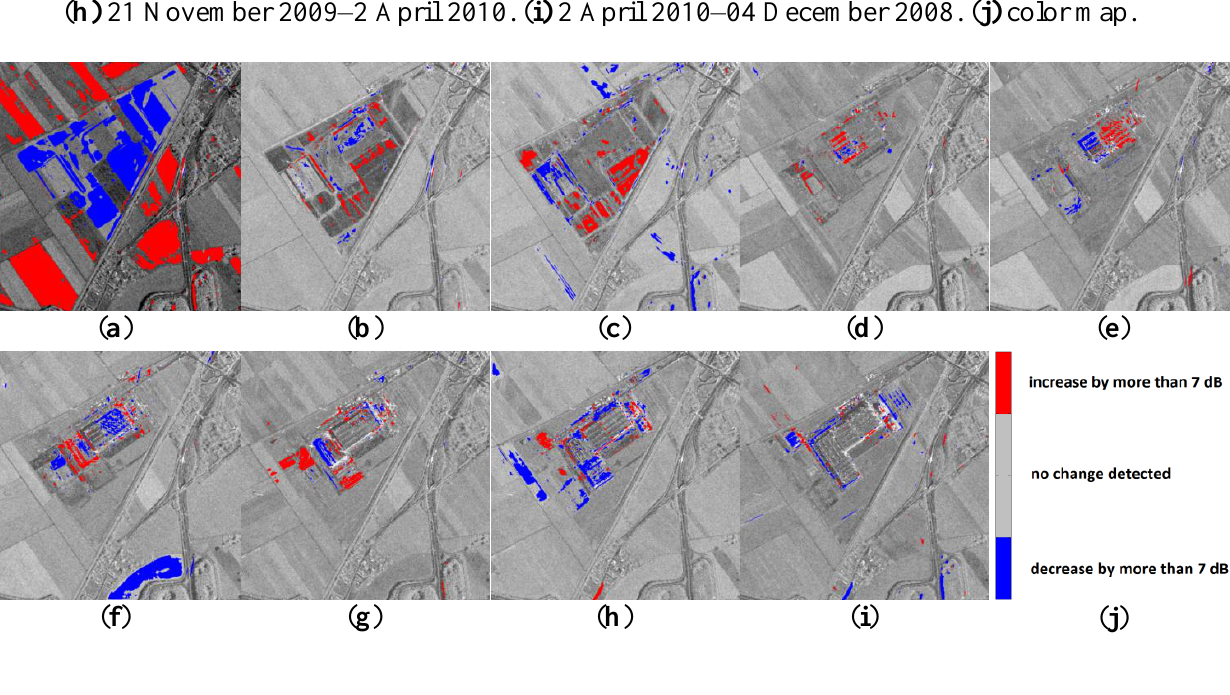
Figure 22. Changes over 7 dB between neighbored image acquisitions detected in the TerraSAR-X time series over Ludwigshafen by the automated Curvelet-based